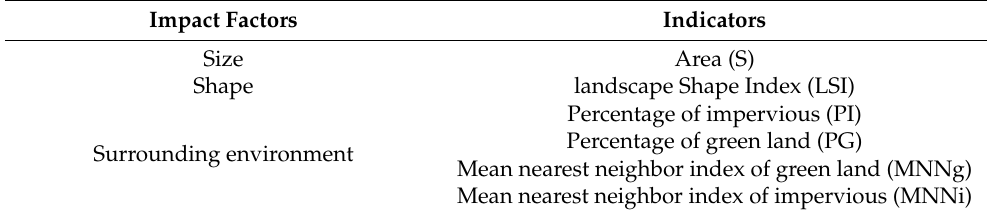
Table 1. WCI impact factors and